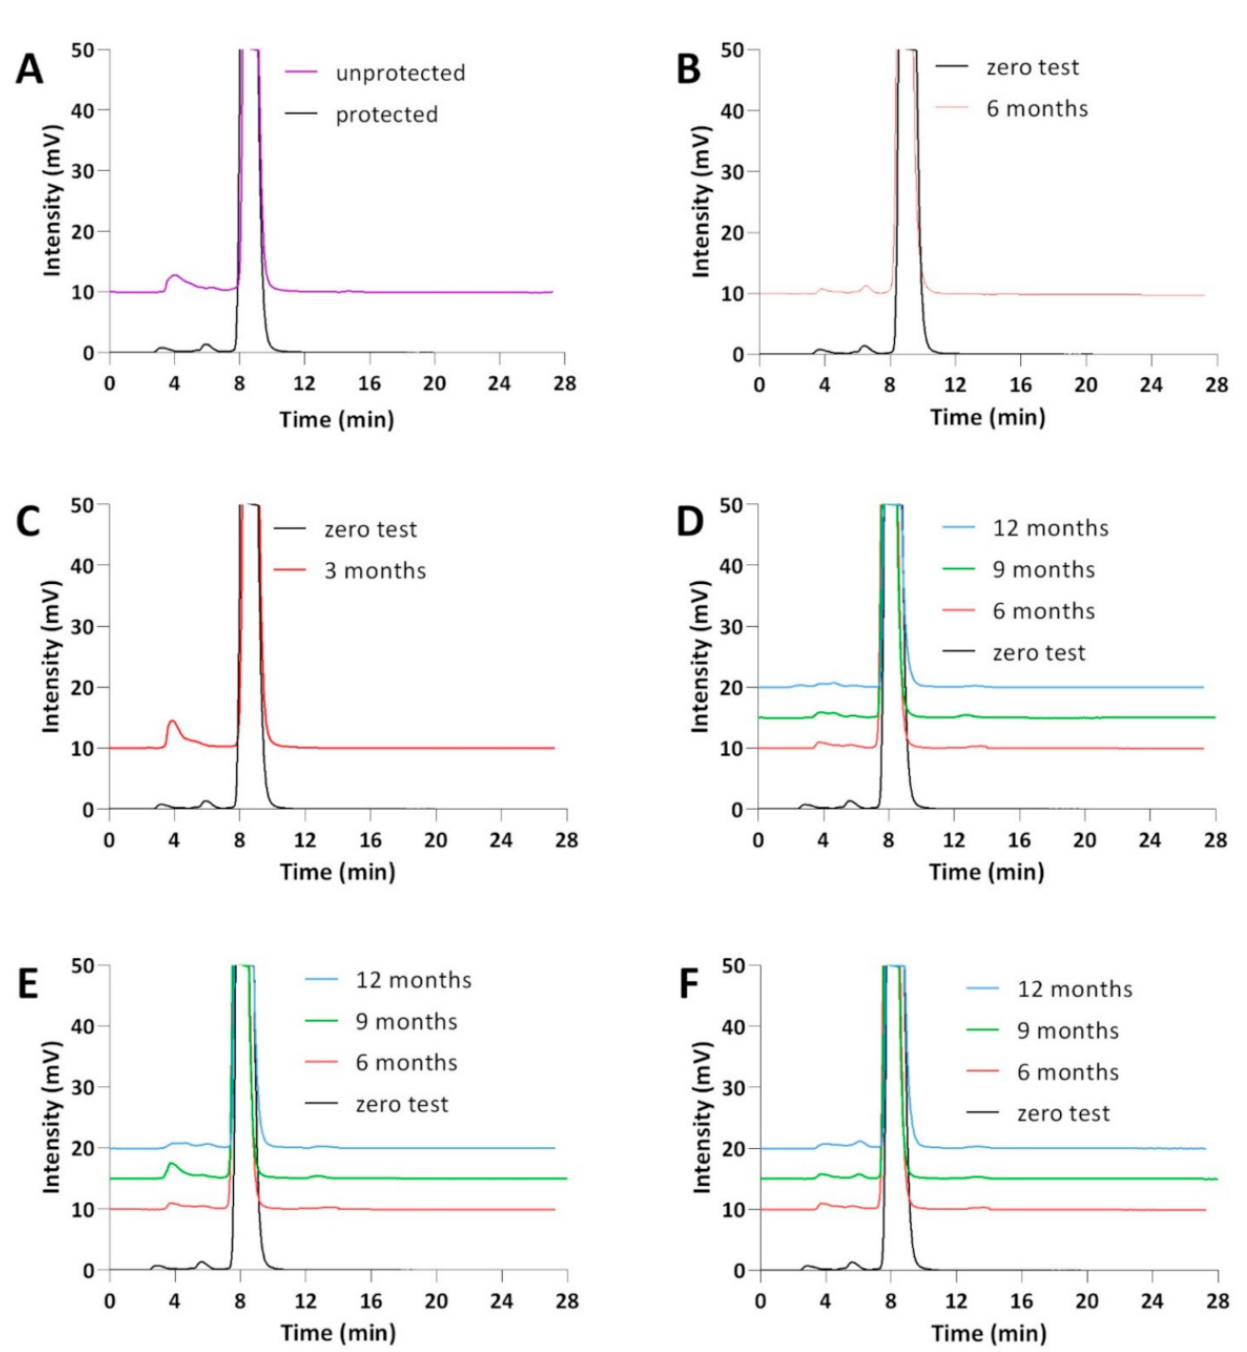
Figure 4. HPLC-UV chromatograms of eye drops with CS (2%) and HA (0.4%) from a chromatographic purity test: ( A ) after exposure to light (minims, 250 W/m 2 ; 1.2 × 10 6 lux · h); ( B ) stored in bottles under controlled conditions (40 ◦ C/75% RH); ( C ) stored in minims under controlled conditions (40 ◦ C/75% RH); ( D ) stored in bottles under controlled conditions (25 ◦ C/60% RH); ( E ) stored in minims under controlled conditions (25 ◦ C/60% RH); ( F ) stored in minims under uncontrolled conditions (2–8 ◦